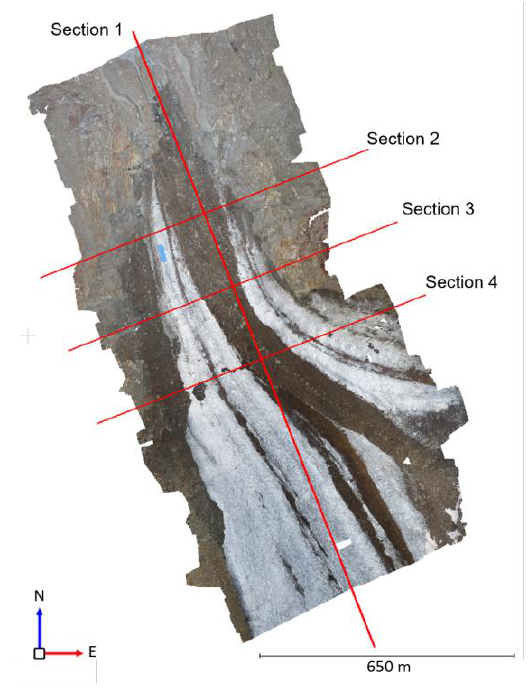
Figure 12. Position of the sections for the comparison between DPCs obtained from 2014 and 2016 datasets.